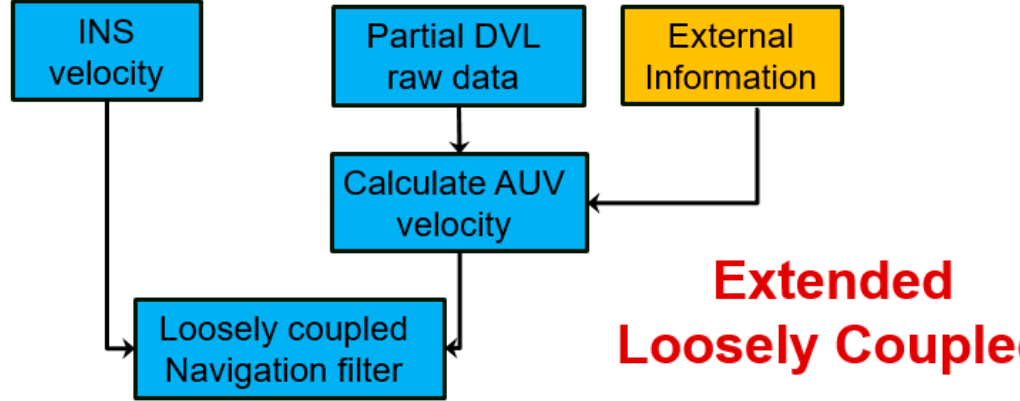
Figure 6. Extended loosely coupled (ELC) shame for utilizing partial measurements from the DVL.